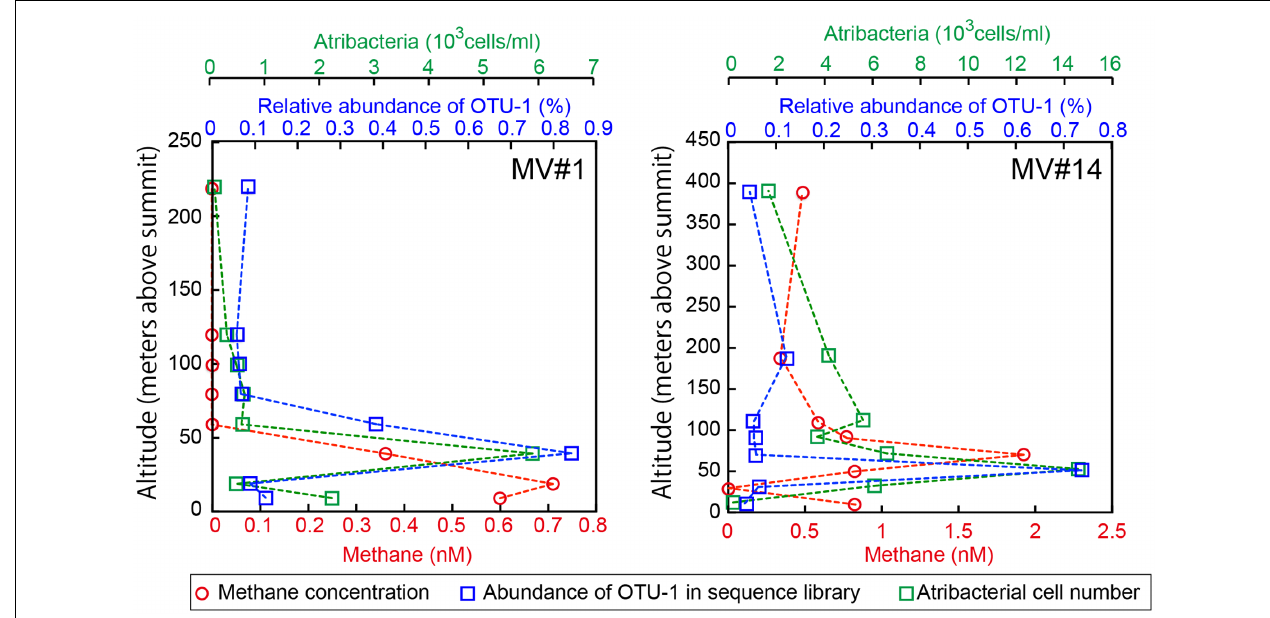
FIGURE 6 | Depth profiles of methane concentrations, relative abundance of OTU-1 in the sequence library, and cell numbers of Atribacteria as detected by CARD-FISH using probe Atri578. OTU-1 is the most abundant OTU affiliated with Atribacteria.